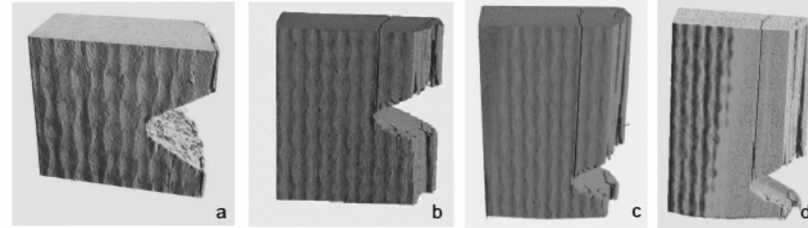
Fig. 9. Left-side view before testing (a); after 250 impacts (b); after 400 impacts and after 600 impacts (d).